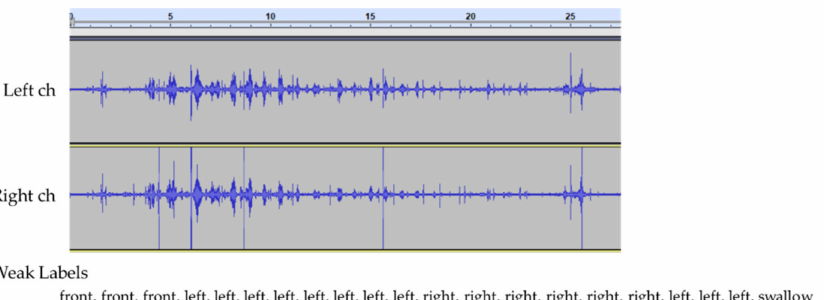
Figure 4. Sample recorded eating sound (two-channel) and event sequence (weak labels) for one